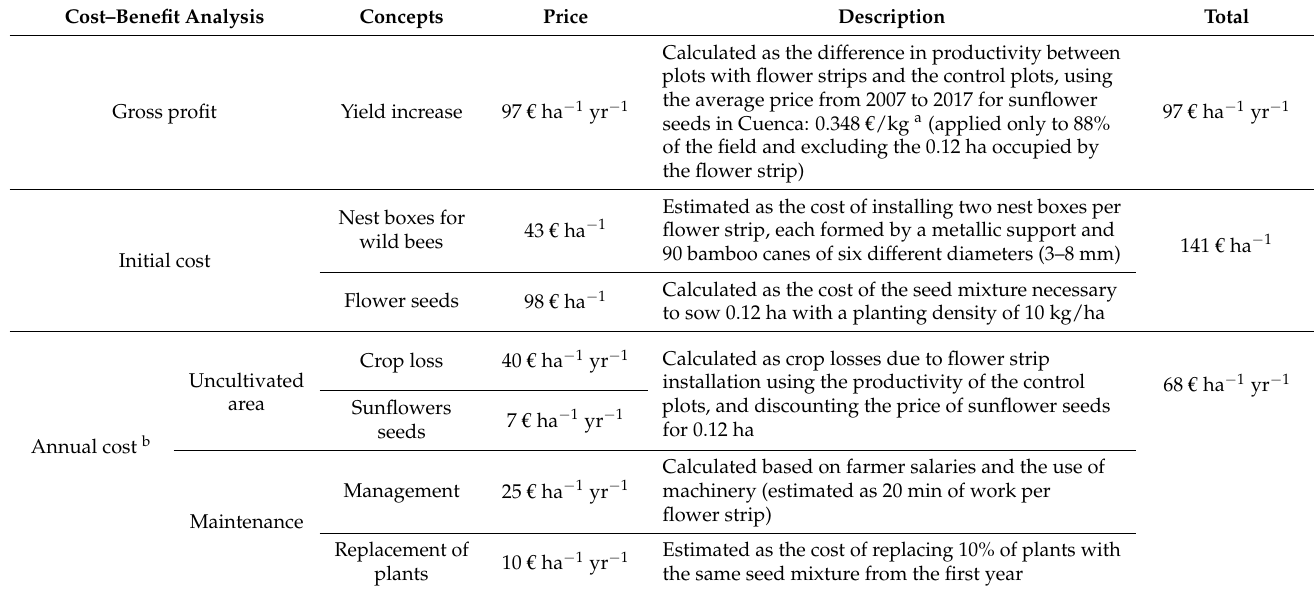
Table 1. The costs and benefits used to calculate the net present value, estimated per